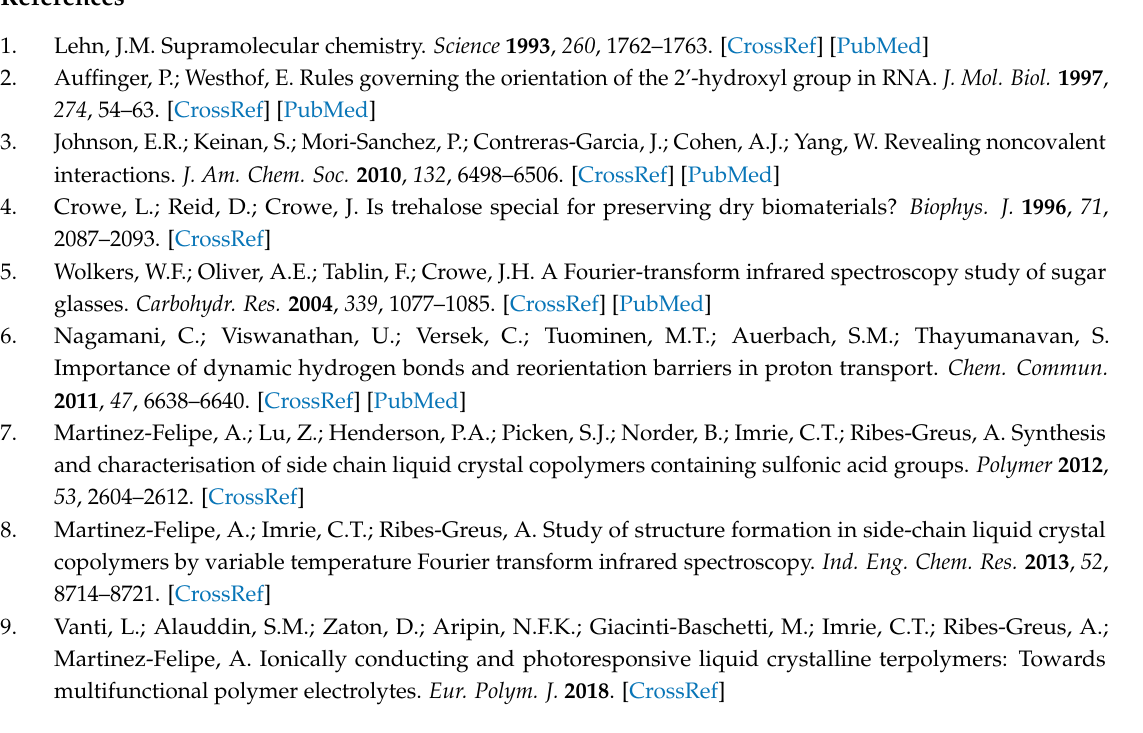
Supplementary Materials: The following are available online. Figure S1: materials preparation, Figures S2 to S15: FT-IR results and proposed models by DFT, Figures S16 to S28: theoretical IR spectra, Tables S1 to S4: experimental and predicted IR frequencies, Table S5: lengths of the hydrogen bonds estimated by